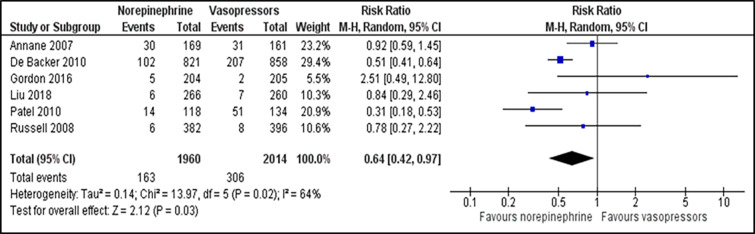
Comparison between norepinephrine and vasopressors for the outcome of the incidence of arrhythmia.M-H, Mantel-Haenszel method; CI, confidence interval.